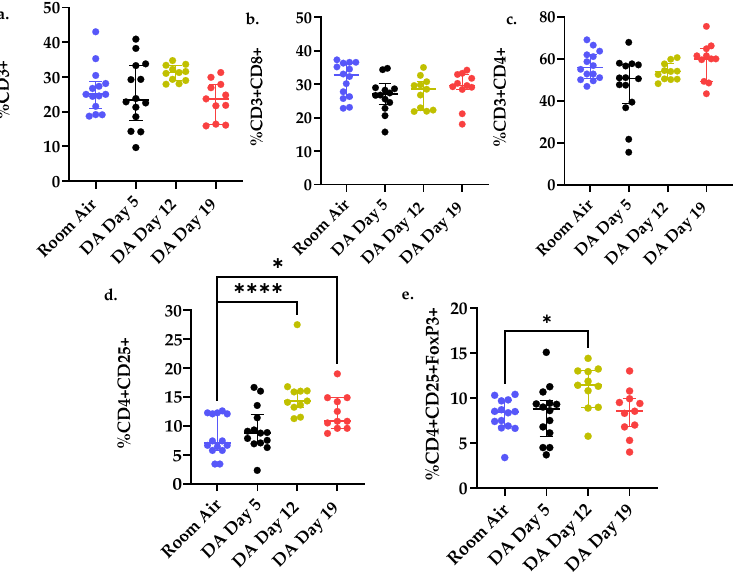
Figure 4. Percent (%) T cell populations from rat lung homogenates exposed to room air (blue) versus DA-exposed Day 5 (black), Day 12 (yellow), and Day 19 (red). ( a ) CD3 + %, ( b ) CD3 + CD8+%, ( c ) CD3+CD4+%, ( d ) CD4+CD25+%, and ( e ) CD4 + CD25 + Foxp3 + % lung T cells. * p < 0.05, ** p < 0.01, **** p < 0.0001. Cumulative results from 3 separate exposures (n = 11–14/group); differences in group size are due to animal death at later time points (D12, D19).